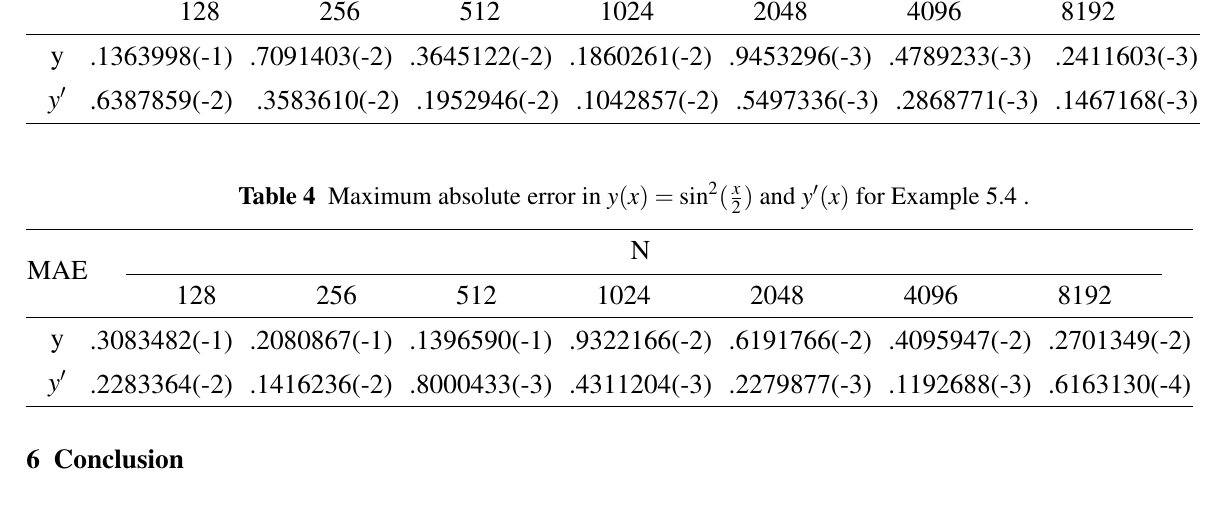
Table 3 Maximum absolute error in y ( x ) = ( 1 + x ) − 1 and y (cid:48) ( x ) for Example 5.3 .